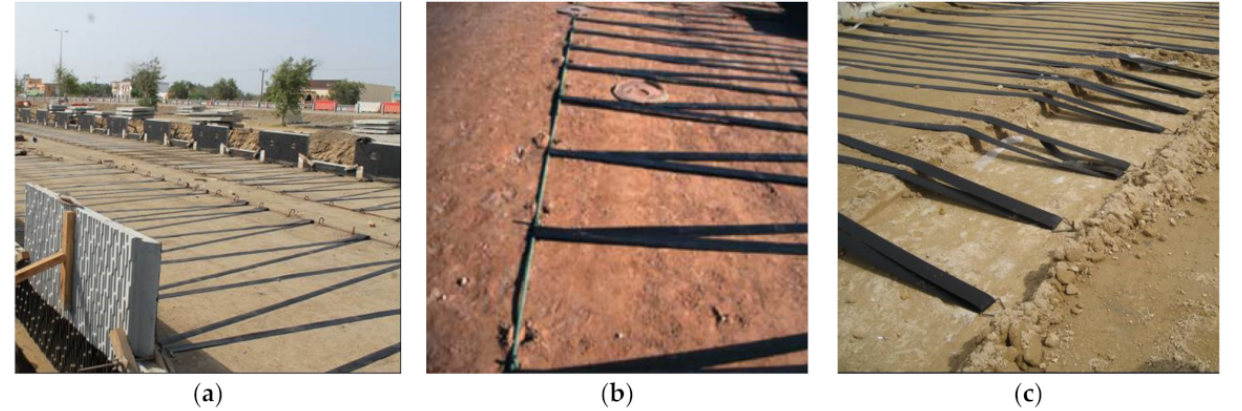
Figure 2. On-site polymeric strip installation examples: ( a ) back-to-back wall case, ( b ) longitudinal bar back anchorage and pegs, and ( c ) trench and triangle anchorage. (Photographs courtesy of VSL Construction Systems—VSoL ® Retained Earth System